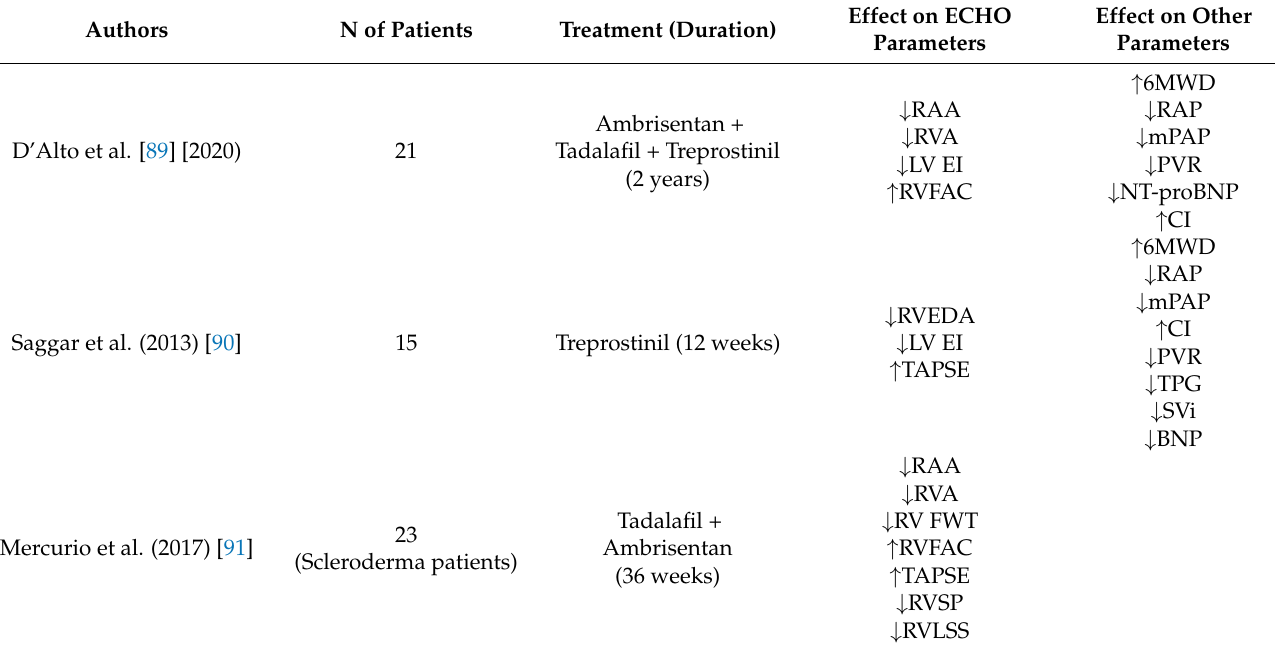
Table 1. Human studies with PAH-targeted therapy and their effect on RV function based on echocardiographic parameters. Authors N of Patients Treatment (Duration)